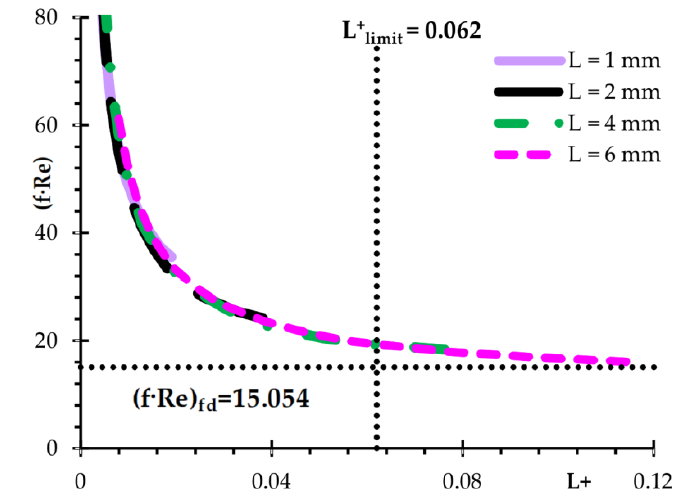
Figure 8. f ∙ Re vs. L + for different channel lengths. Figure 8. f · Re vs. L + for different channel lengths.